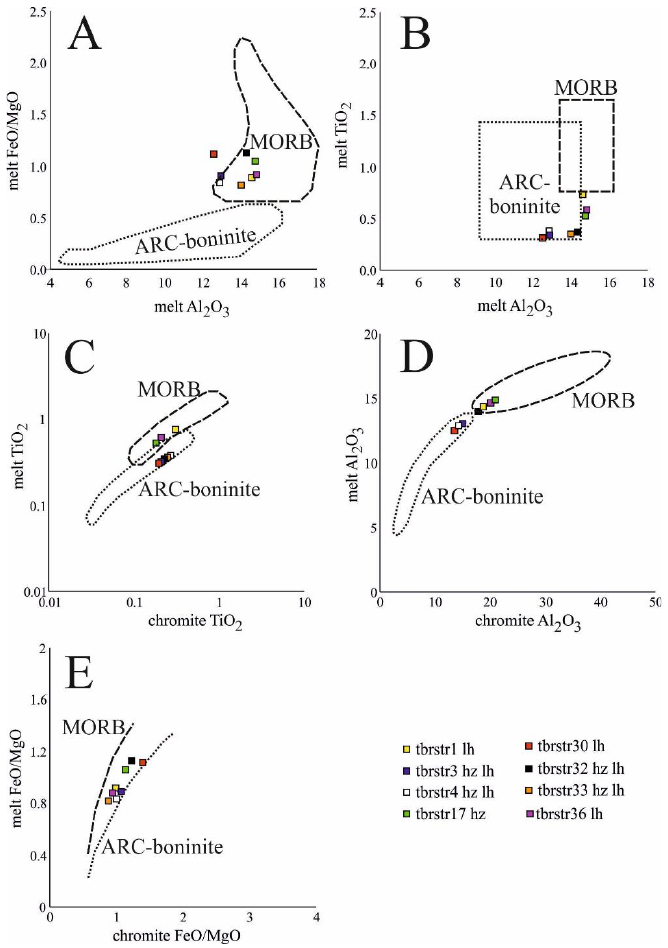
Figure 13. Chromite composition – melt relationships in Kabaena Island chromitites: Al 2 O 3 versus FeO/MgO melt ( A ), melt variation in terms of Al 2 O 3 and TiO 2 ( B ), correlation between TiO 2 (wt%) in chromite and melt ( C ), Al 2 O 3 (wt%) and Al 2 O 3 in the melt ( D ), and the ratio FeO/MgO in the chromite and in the melt ( E ). The variations between the FeO/MgO ratio versus Al 2 O 3 in the melt are consistent with a MORB origin (Figure 13A). On the contrary, the correlation TiO 2 versus Al 2 O 3 re- sembles those related with arc-boninite melts (Figure 13B). The calculated amount of Al 2 O 3 and TiO 2 in the melts plotted versus the Al 2 O 3 and TiO 2 concentrations of the host chromite reveals a bimodal character of Kabaena Island chromitite, since a group of sam- ples falls in the MORB field and another group in those of arc (Figure 13C,D). The data in the binary diagram FeO/MgO ratio in the melt and the FeO/MgO ratio in the chromite plot in a narrow area comprised between MORB and the arc (Figure 13E).